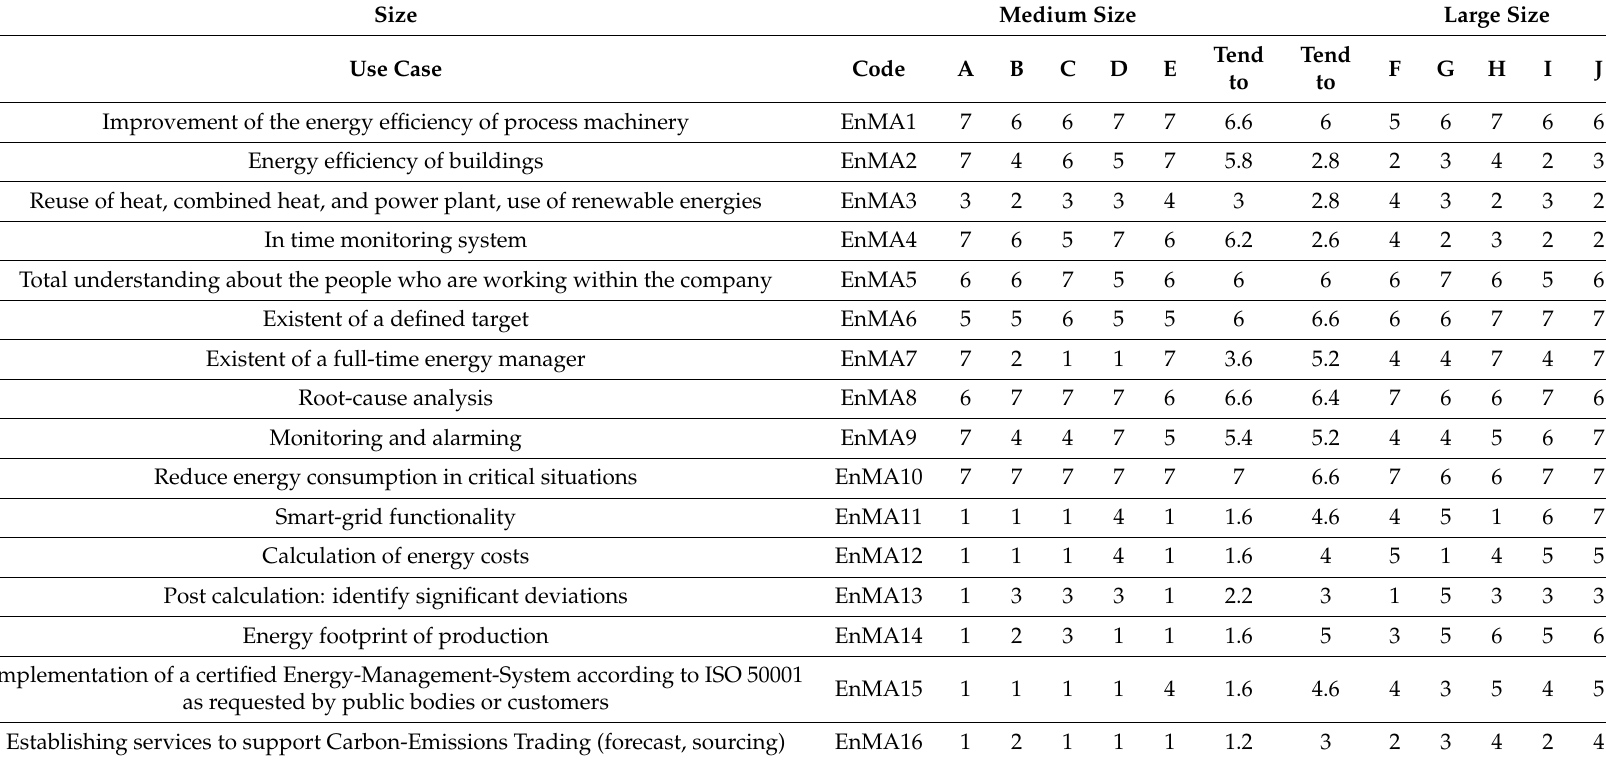
Table 2. Results of energy management assessment (1 = Irrelevant, 4 = somewhat relevant, 7 = highly